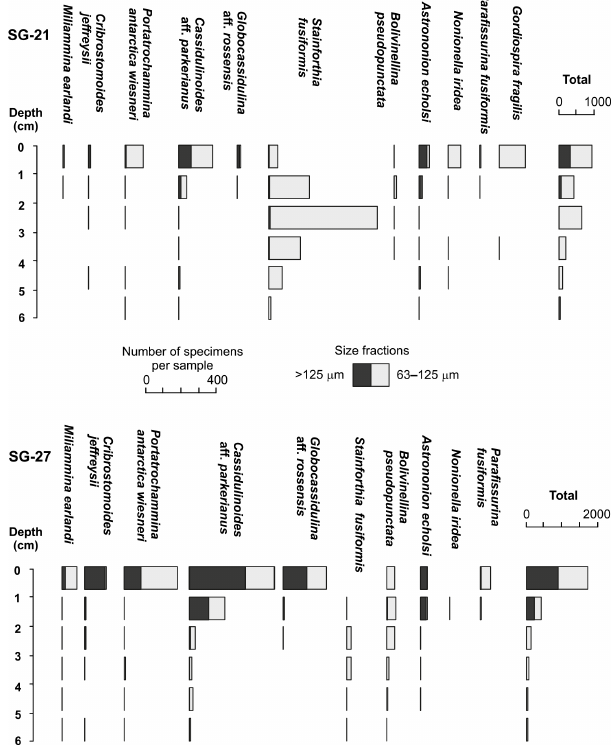
Figure 7. Abundances in numbers per sample of stained foraminifera in two short cores taken at stations SG-21 and SG-27. Note the different scales for the specific and total